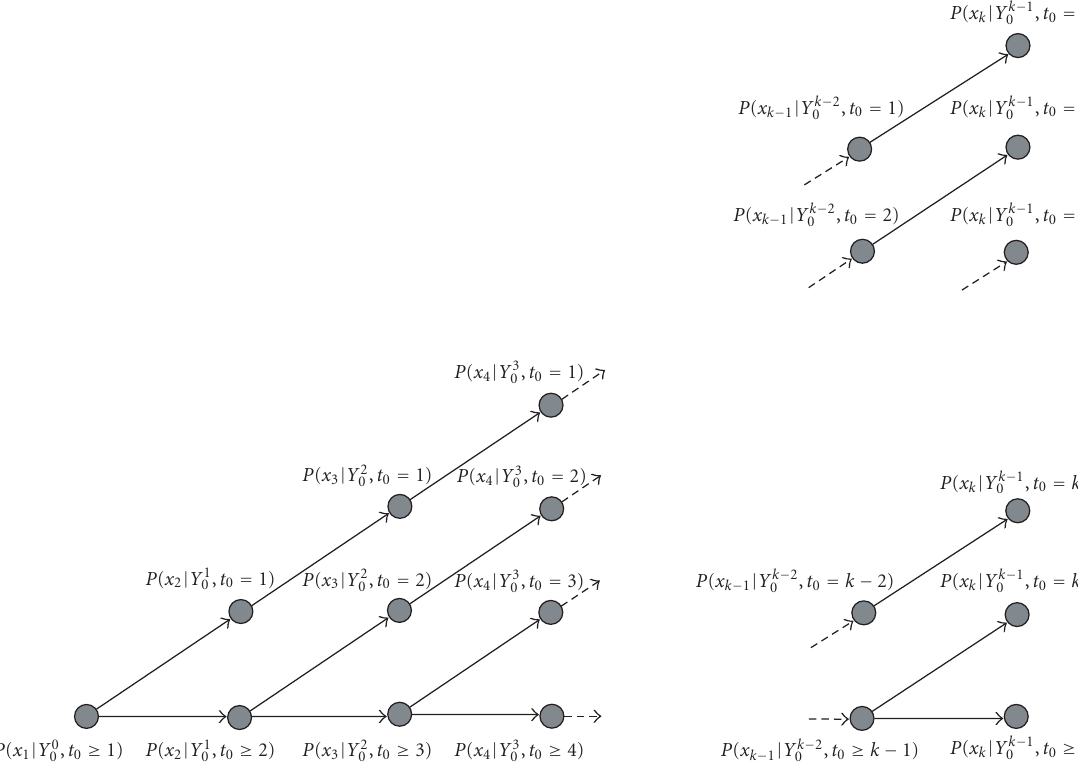
Figure 1: Combination of nonlinear filters used in the CUSUM change detection